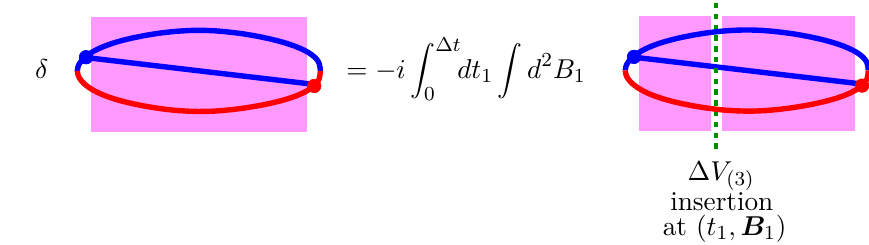
Figure 11 . First-order perturbative correction to the integrand of the leading-order hard splitting rate in figure